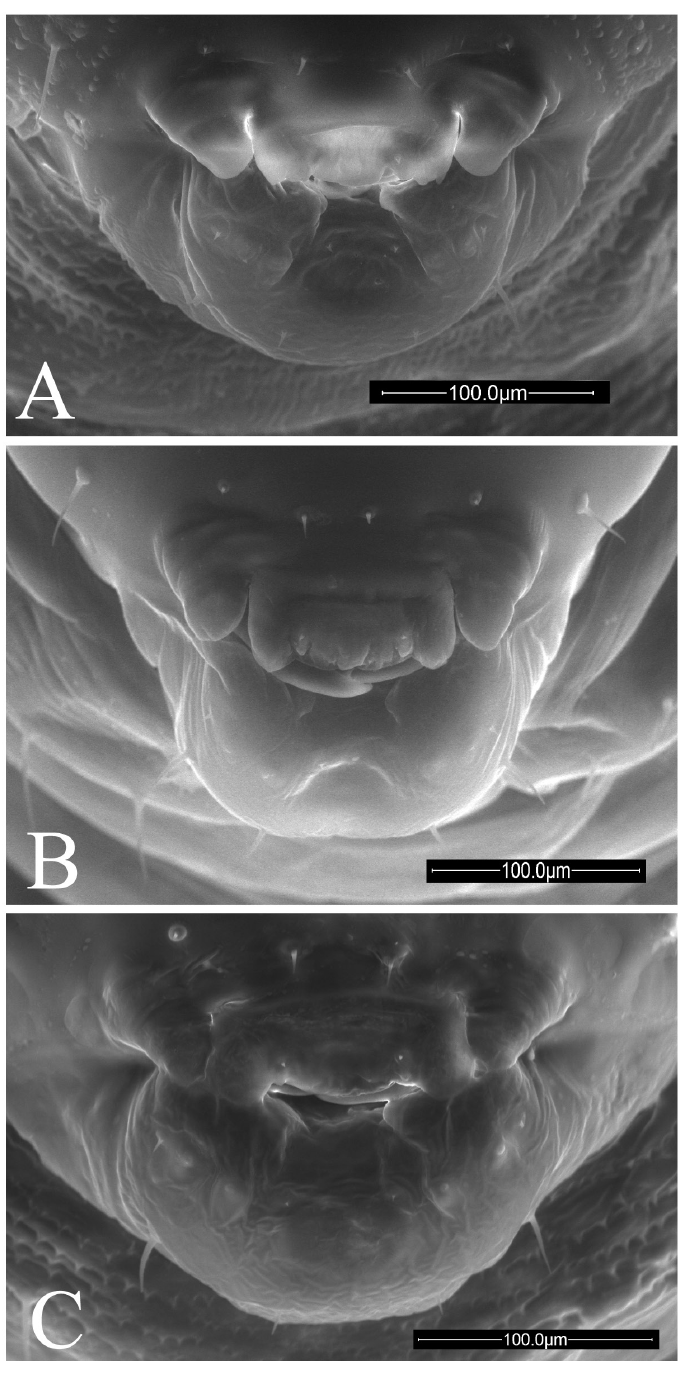
Figure 10. Anterior views of mouthparts of Ormyrus terminal-instar larvae. A O. pomaceus ex Plagiotro- chus razeti (Cynipidae) B O. rufimanus C O. wachtli